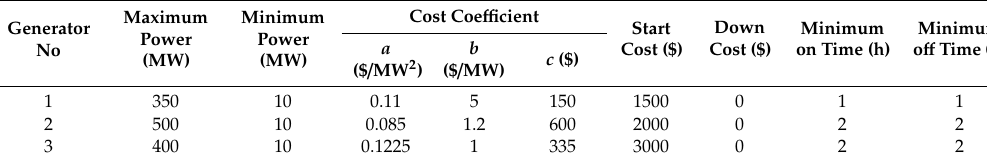
Table 1. Thermal power generator parameters.